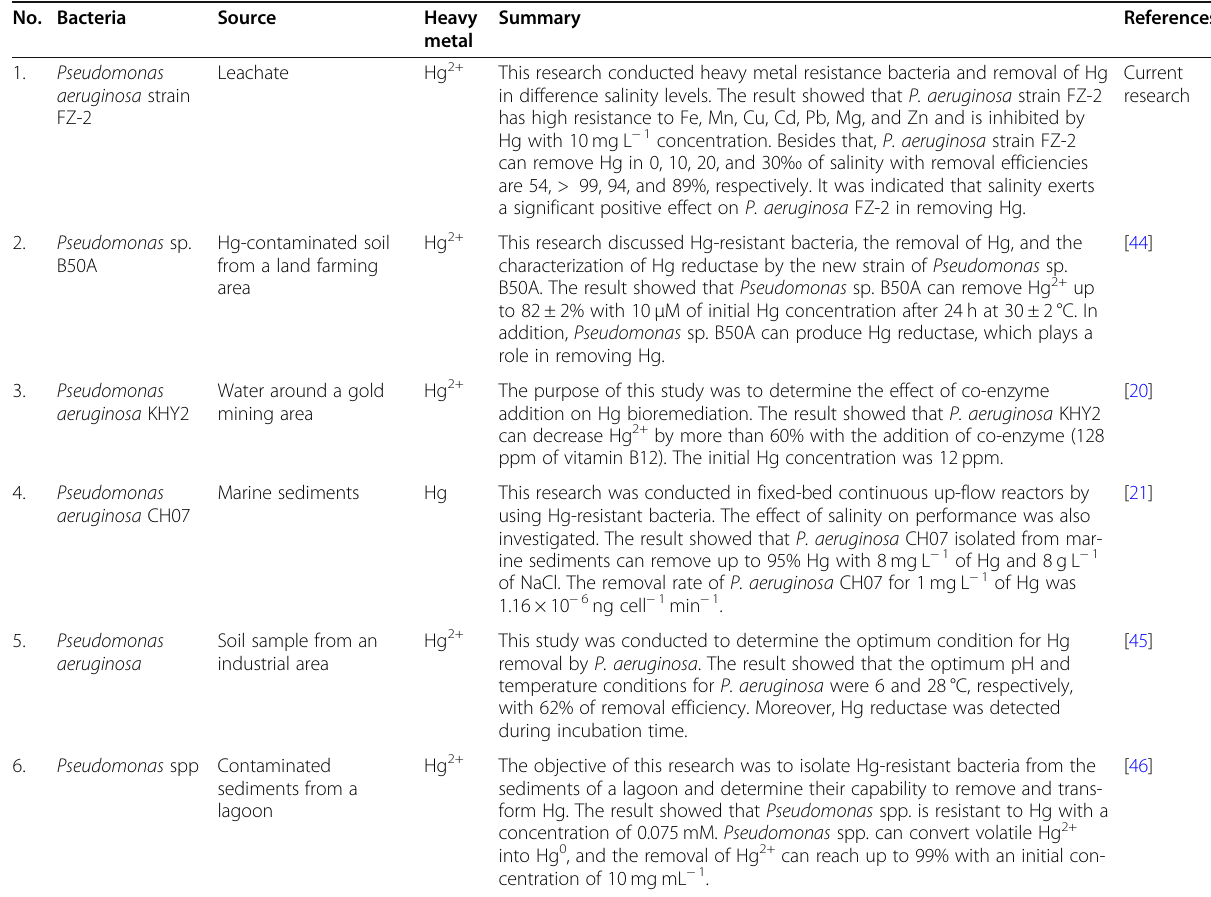
Table 5 Summary of studies related to Hg removal by